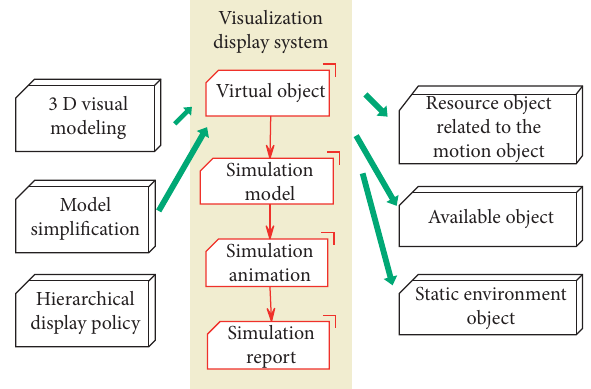
Figure 4: 3D visualization display and realization in